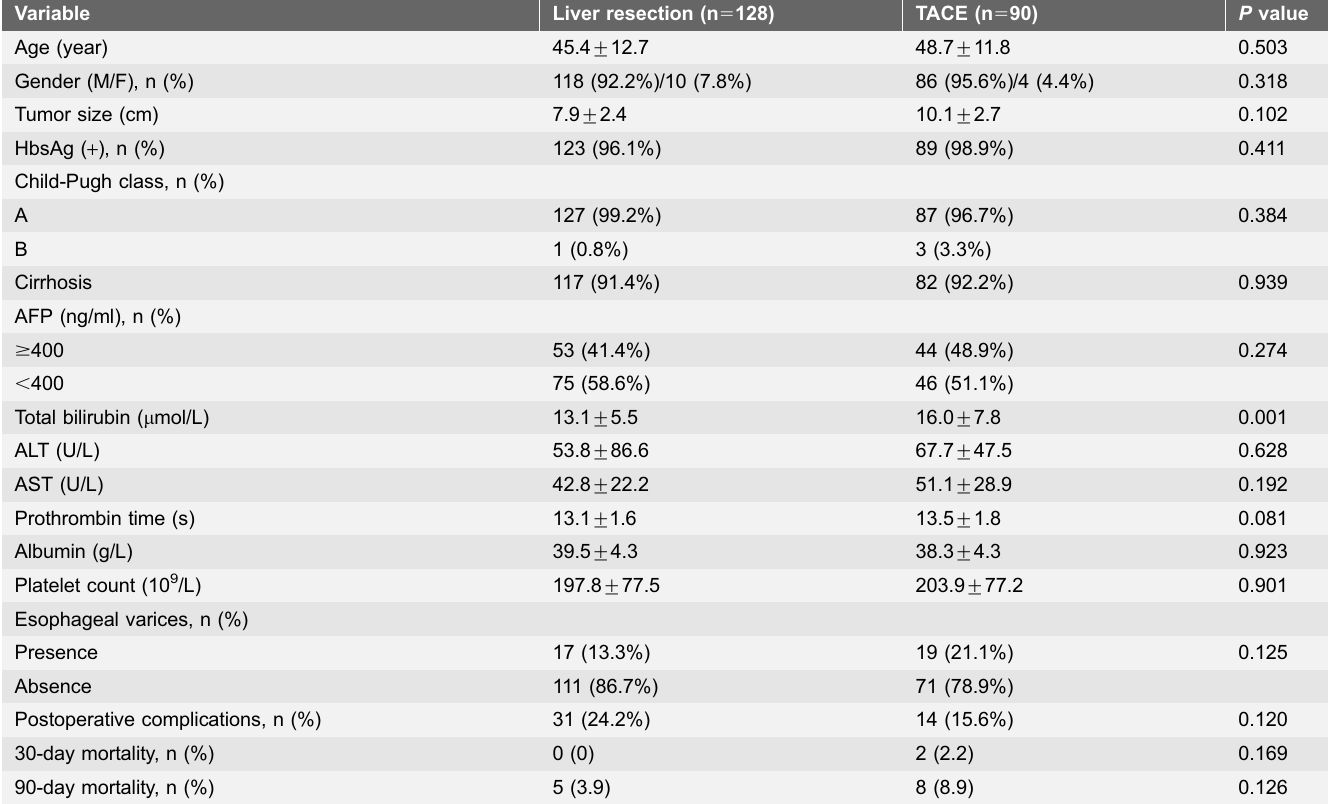
Table 1. Comparison of preoperative clinicopathologic data of patients receiving liver resection (LR) or transarterial chemoembolization